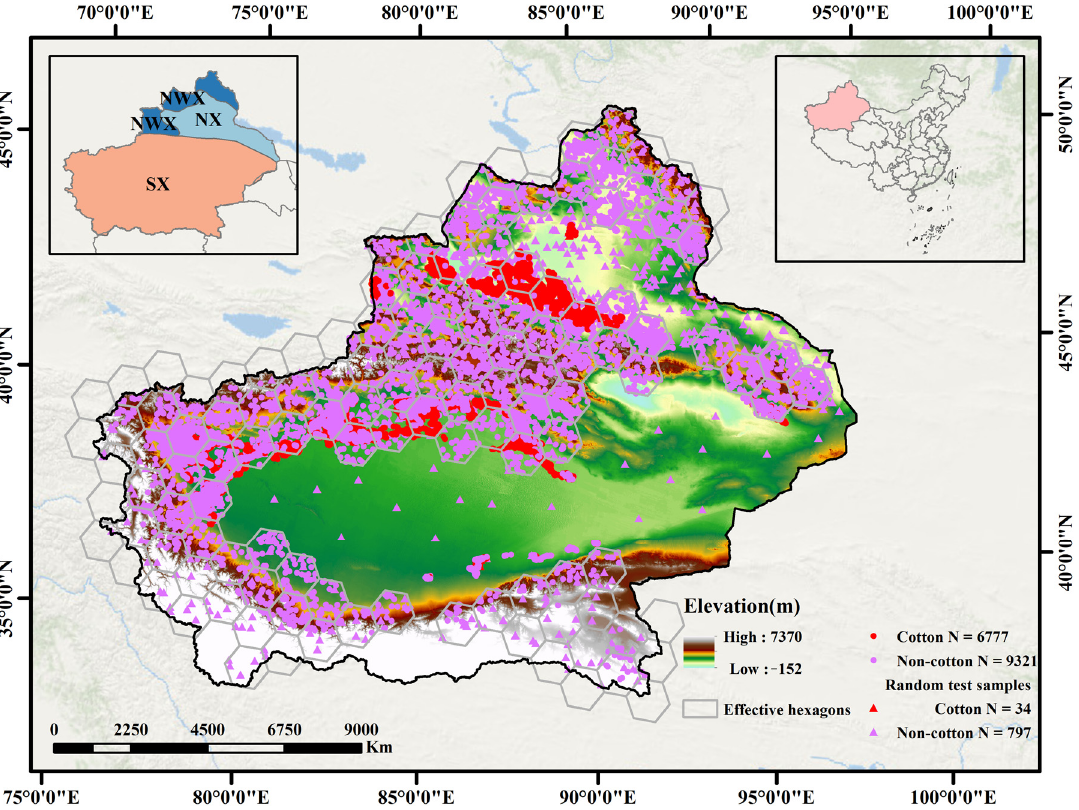
Figure 1. Study area of the Xinjiang showing location of the cotton/non-cotton samples. The entire Xinjiang was divided by the natural zoning of Chinese agriculture into northern Xinjiang (including NX and NWX) and southern Xinjiang (SX). Note: This map is based on the standard map with the approval number GS (2020)4619 downloaded from the standard map service website of the Ministry of Natural Resources of China, and the base map has not been modified.